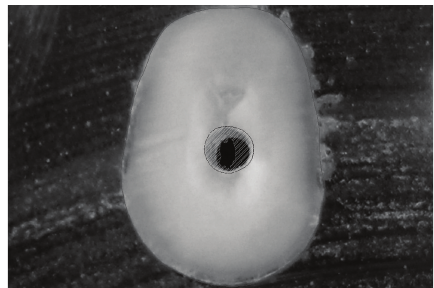
Figure 1: Example of area before and after reaming.